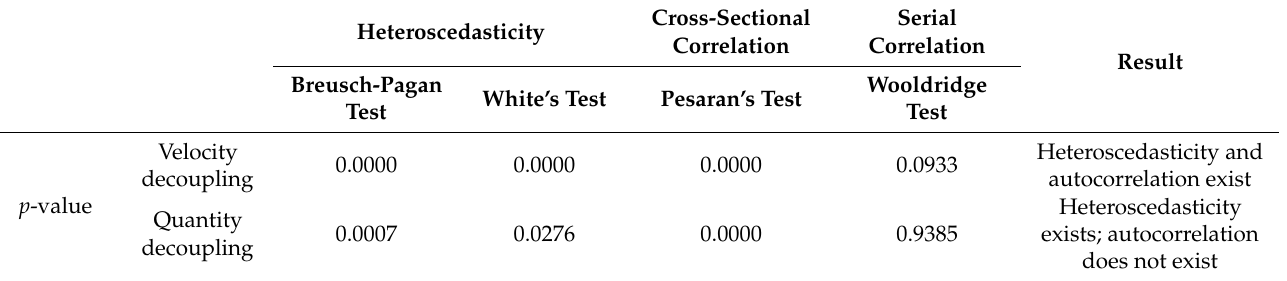
Table 6. Heteroscedasticity and autocorrelation